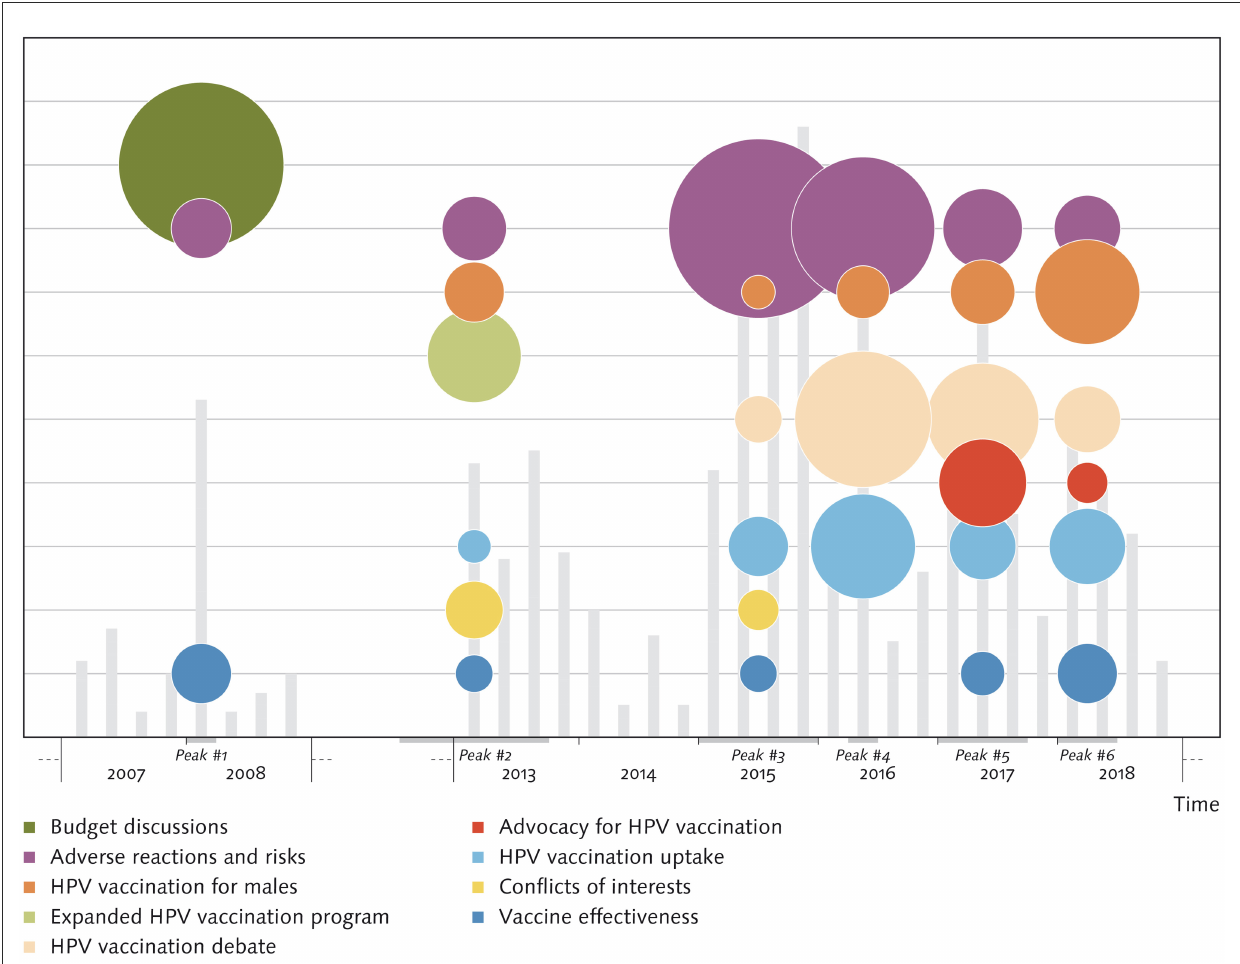
FIGURE2 Main topics across the six peaks [time indicated by (gray bars)]. The sizes of the bubbles within each peak are relative to the total number of articles published in the peak period, and they have been normalized across all six peaks. See Supplementary material for more information about bubble